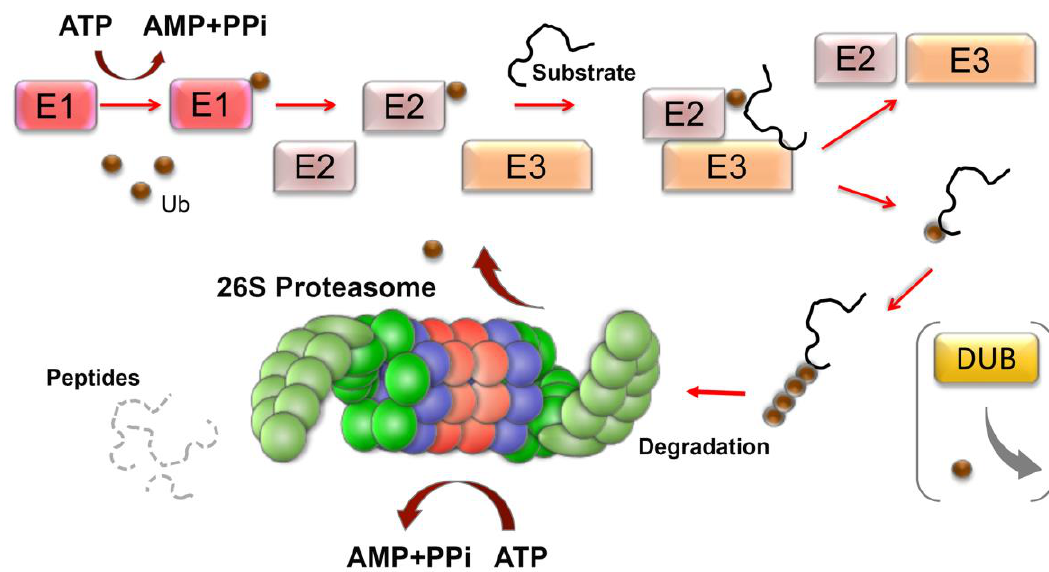
Figure 2. The ubiquitin-proteasome system of cell proteostasis in brief. The ubiquitylation system consists of activating enzymes (E1s), conjugating enzymes (E2s), and ligase enzymes (E3s) that result in the activation and conjugation of the 76 amino-acid ubiquitin (Ub) onto the lysine residues of targeted proteins. After the first ubiquitin has been attached, the E3 can elongate the ubiquitin chain by creating ubiquitin–ubiquitin isopeptide bonds. Ubiquitination can be reversed from the substrate by deubiquitinating enzymes (DUBs). Polyubiquitinated proteins are recognized and degraded by the 26S proteasome with the release of short peptides and reusable ubiquitin moieties.